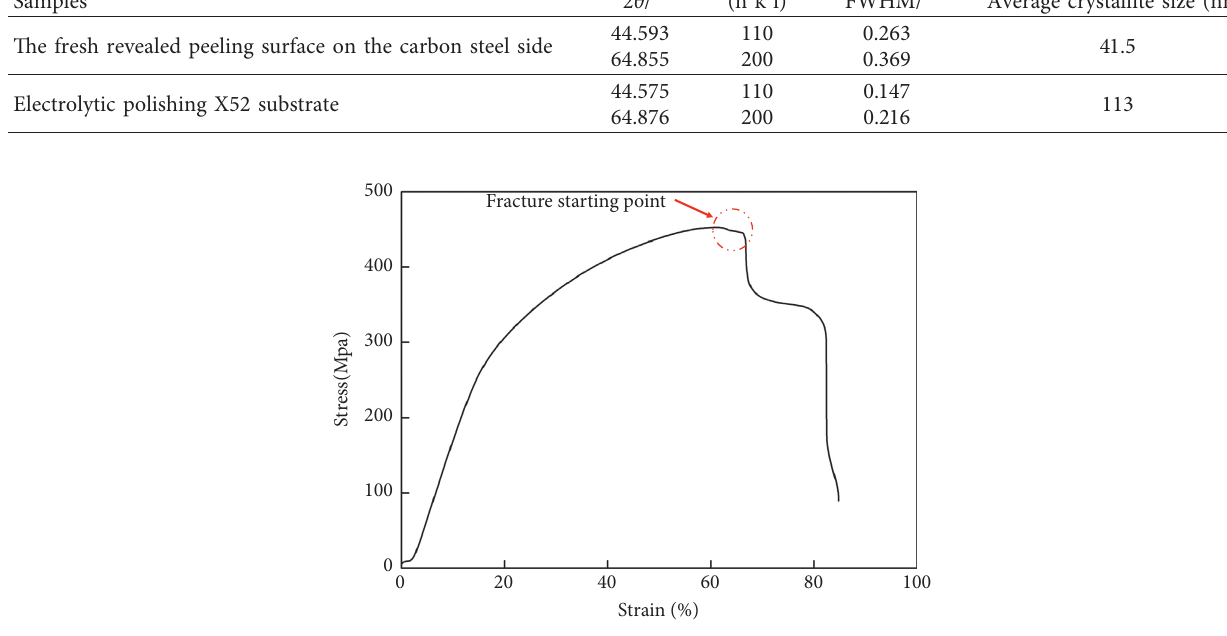
Figure 6: Stress-strain curve of composite plate shear test. Table 3: The interface shear strength reported in